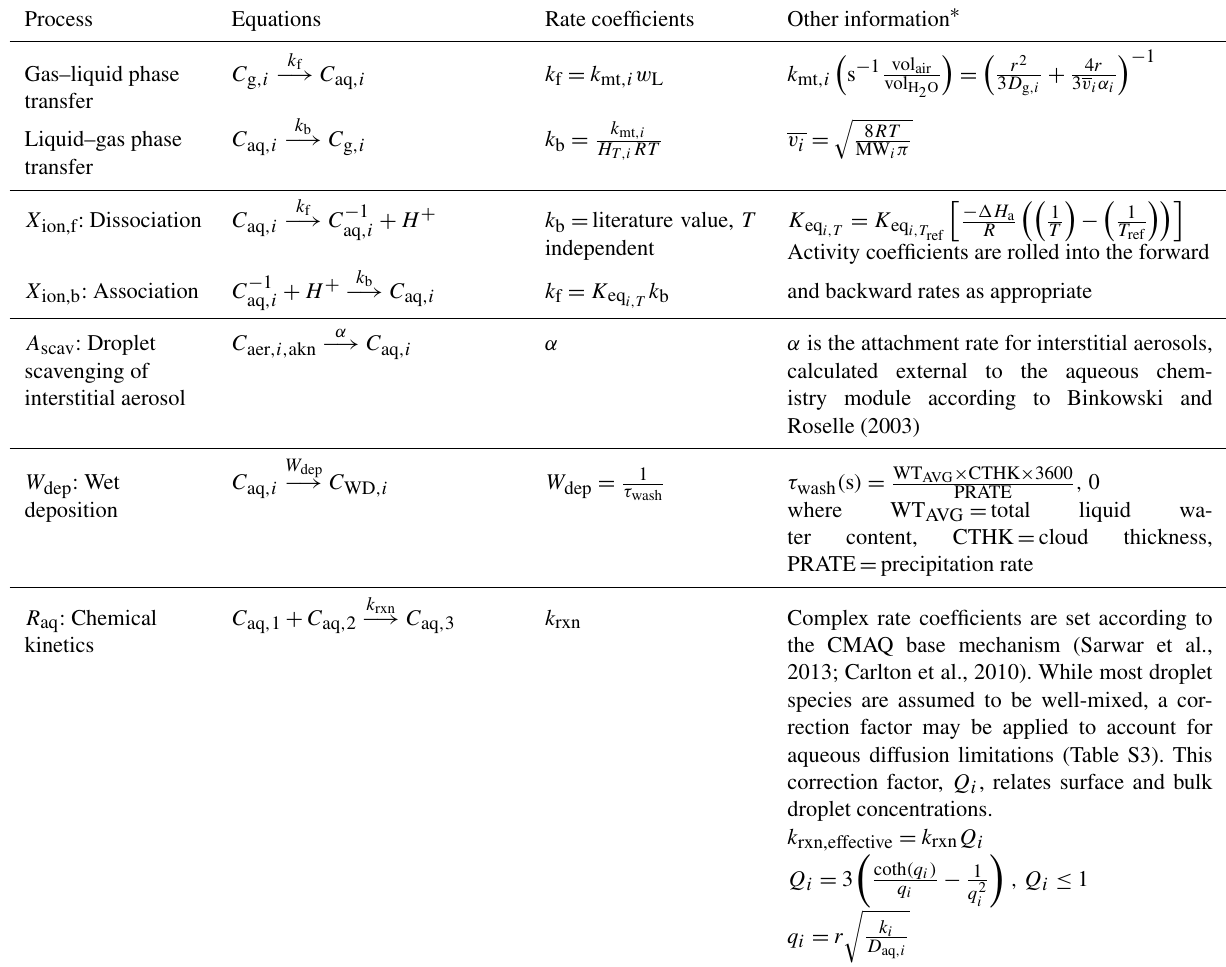
Table 2. Modeled processes and associated rate coefficients and equations. Process Equations Rate coefficients Other information